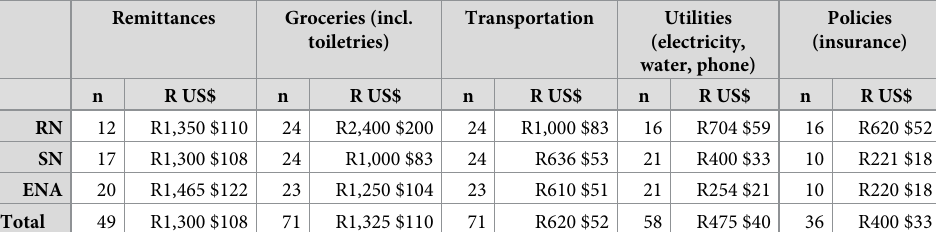
Table 7. Median monthly expenditures by tier of nurse.